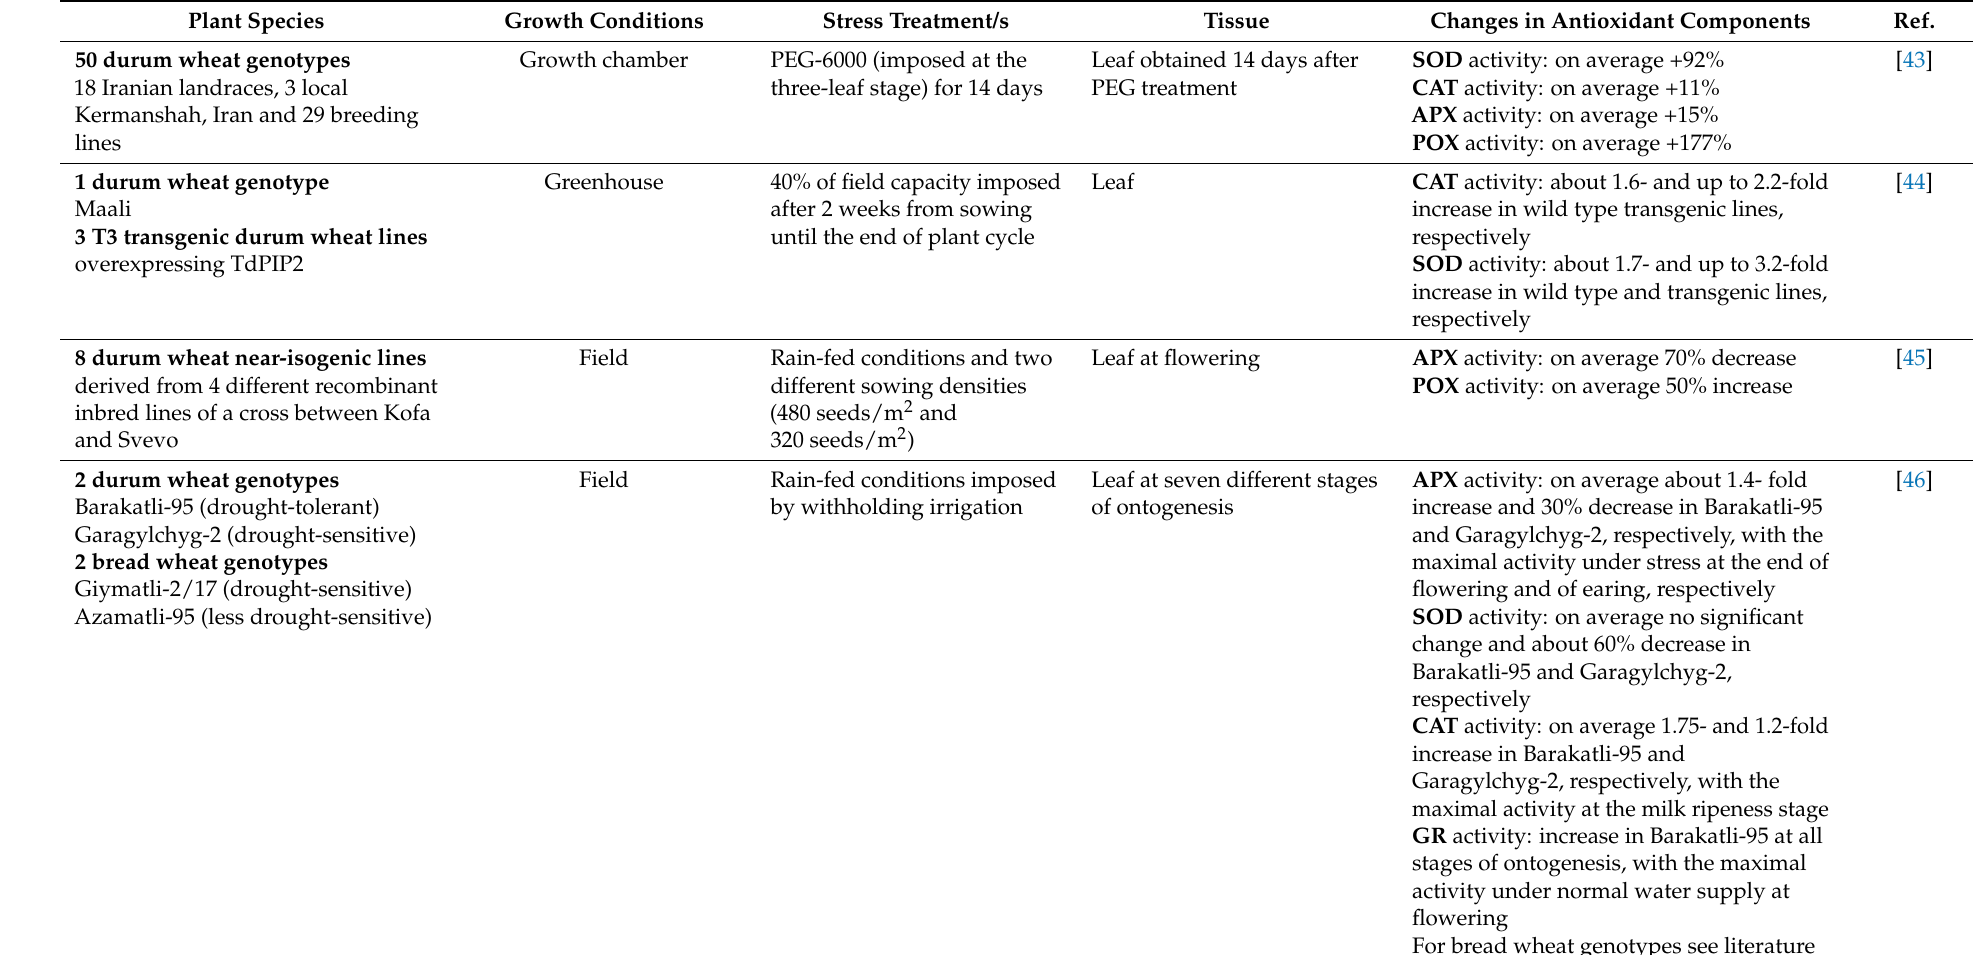
Table 1. Changes in the antioxidant defence system in durum wheat under drought stress. Effects were estimated from graphs, figures and tables if not directly given in the text or